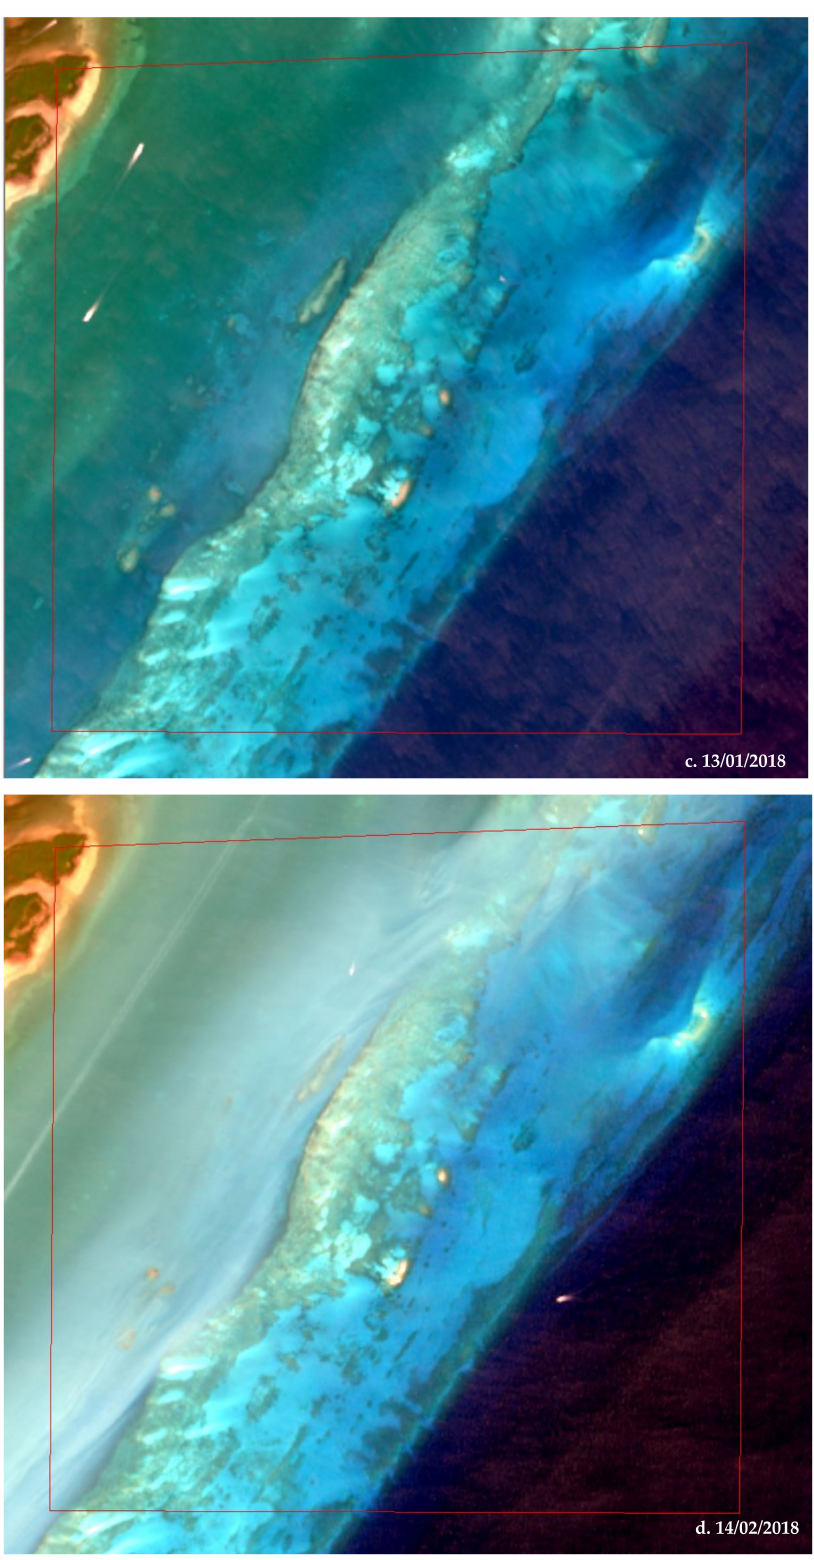
Figure 5. ( a – d ) Maps showing di ff erent confounding factors that might have a ff ected SDB estimates from some images. 1: Boat-generated wake. 2: Plume emerging from a near river discharge. 3: Moving boats. Sun glint can be observed in Figure 5c,d as visible texture around the southeastern part of the